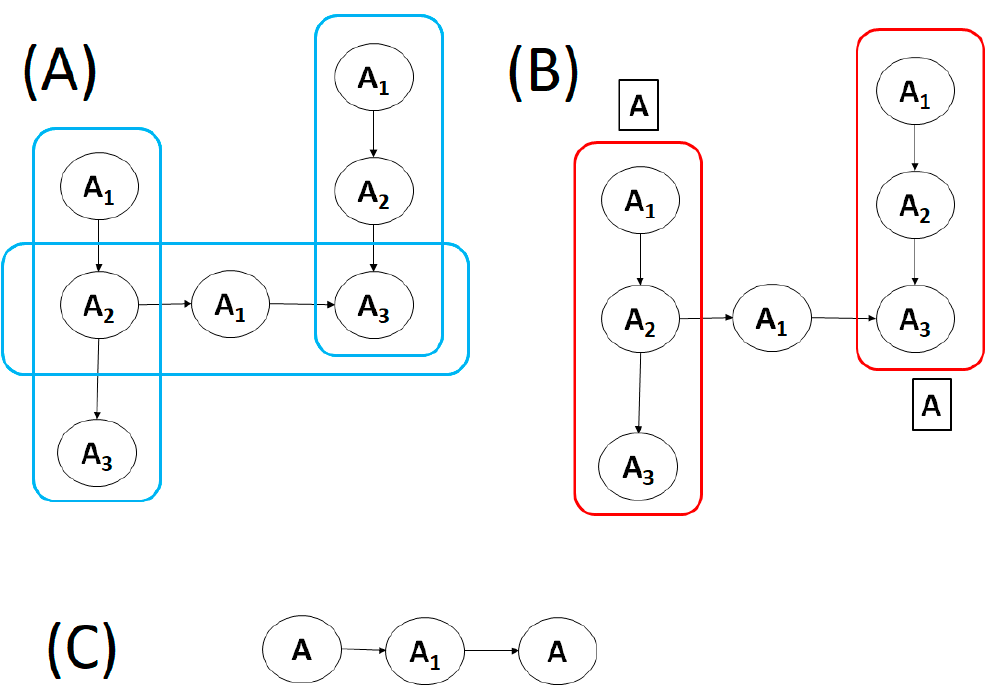
Figure 6. ( A ) Conflict resolution example in a graph with three occurrences of the path { A 1 → A 2 → A 3 }, highlighted with a blue box for each occurrence. ( B ) Selected abstraction on the occurrences of the paths, highlighted with a red box for each selected occurrence. ( C ) Resulting model.